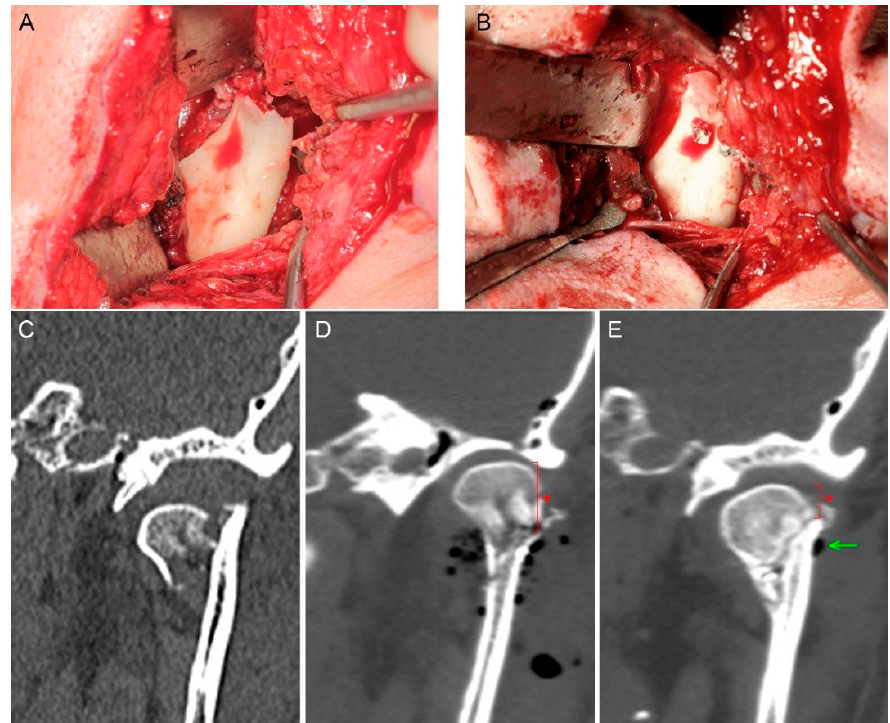
Figure 3. Mandibular head fracture fixation. The phenomenon of reduced mandibular ramus height appeared (asterisk). ( A ) Fracture site. ( B ) Osteosynthesis by two magnesium 1.7 mm × 14 mm screws. ( C ) Pre-op scan—the mandibular head is dislocated downward which shortens the mandibular ramus. ( D ) Fixation by compressive headless screws; visible gas bubbles are the air introduced into the wound during open reduction; height of mandible head is marked by an asterisk. ( E ) 6-month post-op follow-up—fixed bone remodeling, remnants of the produced hydrogen gas (arrow), shortening of the mandibular ramus as a result of the proximal fragment (mandible head) down-shifting along the fissure of the fracture